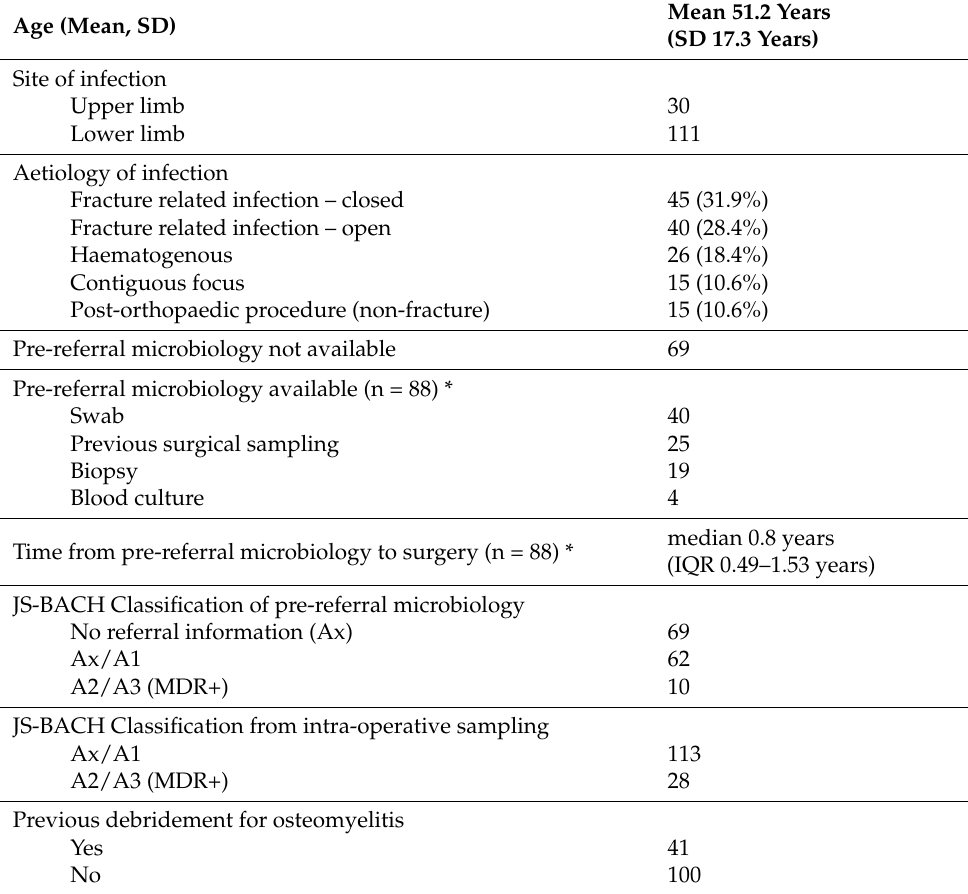
Figure 1. Flow diagram of patient inclusion in the study. Table 1. Demographics, referral, and microbiological information of the 141 patients included.